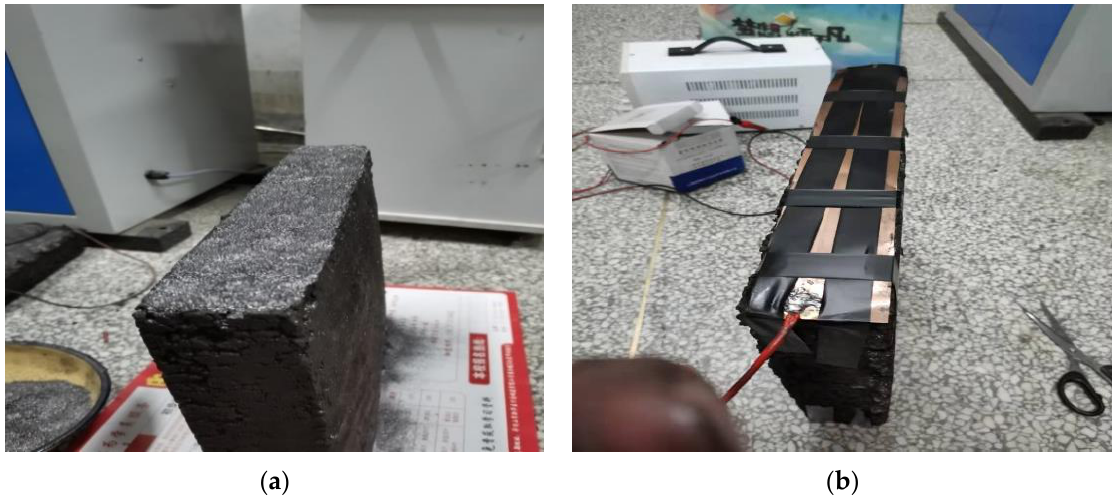
Figure 16. The contact surface of the specimen is covered with graphite. ( a ) Graphite spread, ( b ) Electrode bonding.